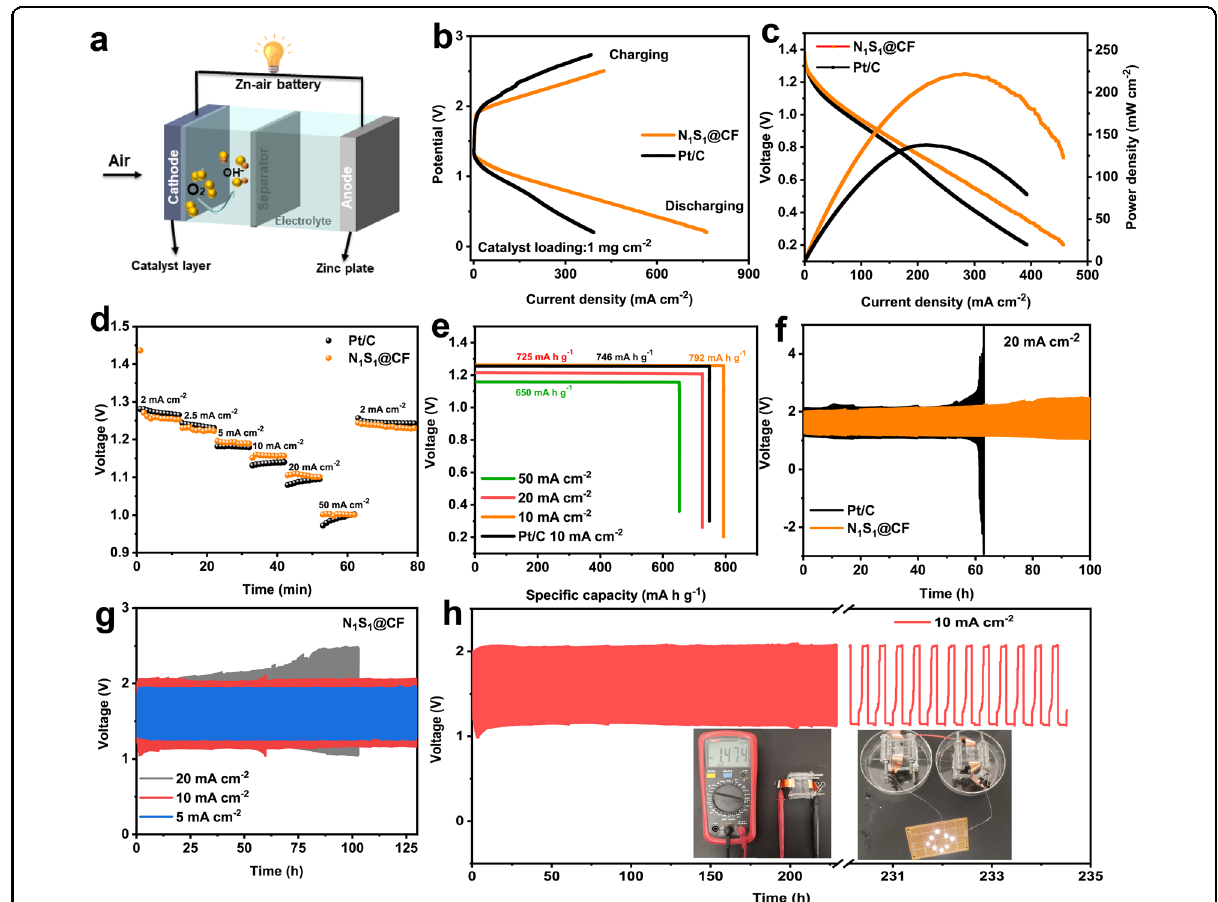
Fig. 4 Characterization of ZABs. a Schematic diagram of a ZAB. b Charge ‒ discharge polarization curves. c Polarization curves and power densities of ZABs loaded with N 1 S 1 @CF and commercial Pt/C. d Constant current discharge curves at different current densities for ZABs with N 1 S 1 @CF as the cathode catalyst. e Mass-to-capacity curves. f Constant current discharge ‒ charge cycle curves at 10 mA cm − 2 for rechargeable ZABs with N 1 S 1 @CF and commercial Pt/C as catalysts. g Constant current discharge ‒ charge cycle curves at different current densities for ZABs. h Constant current discharge ‒ charge cycle curves at 10 mA cm − 2 for ZABs with N 1 S 1 @CF as the catalyst, with the inset showing a homemade ZAB with a multimeter (left) and a white LED ( ∼ 3 V) powered by two integrated ZABs